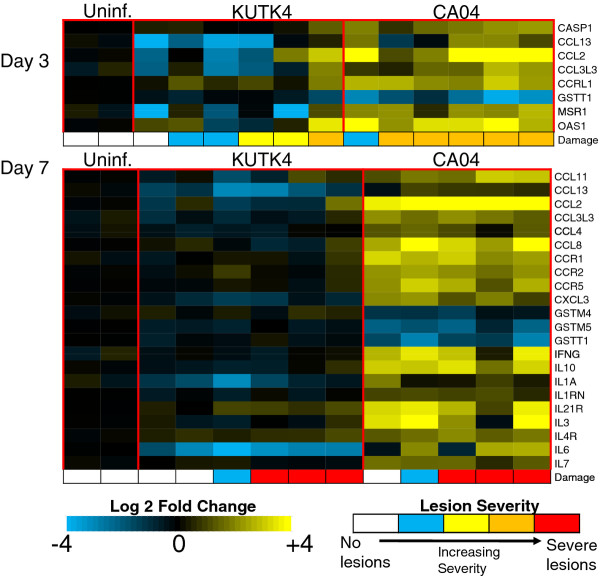
CA04 differentially expressed genes. The transcription profiles of select DE genes on day 3 (top) and day 7 p.i (bottom). Each column represents the gene expression profile of an individual macaque lung tissue sample; gene expression levels for two samples acquired from a uninfected animal are also shown (to the left) for reference. The lesion severity, as described in (11), for each sample is shown at the bottom (Damage) of each heat map. White indicates no lesions; blue represents lung lesions with severe alveolar wall thickening; yellow indicates mild lung lesions with some antigen-positive cells present; orange indicates severe lesions containing a significant number of virus antigen-positive cells; and red indicates severe lung lesions in which the alveolar space was filled with inflammatory cells.